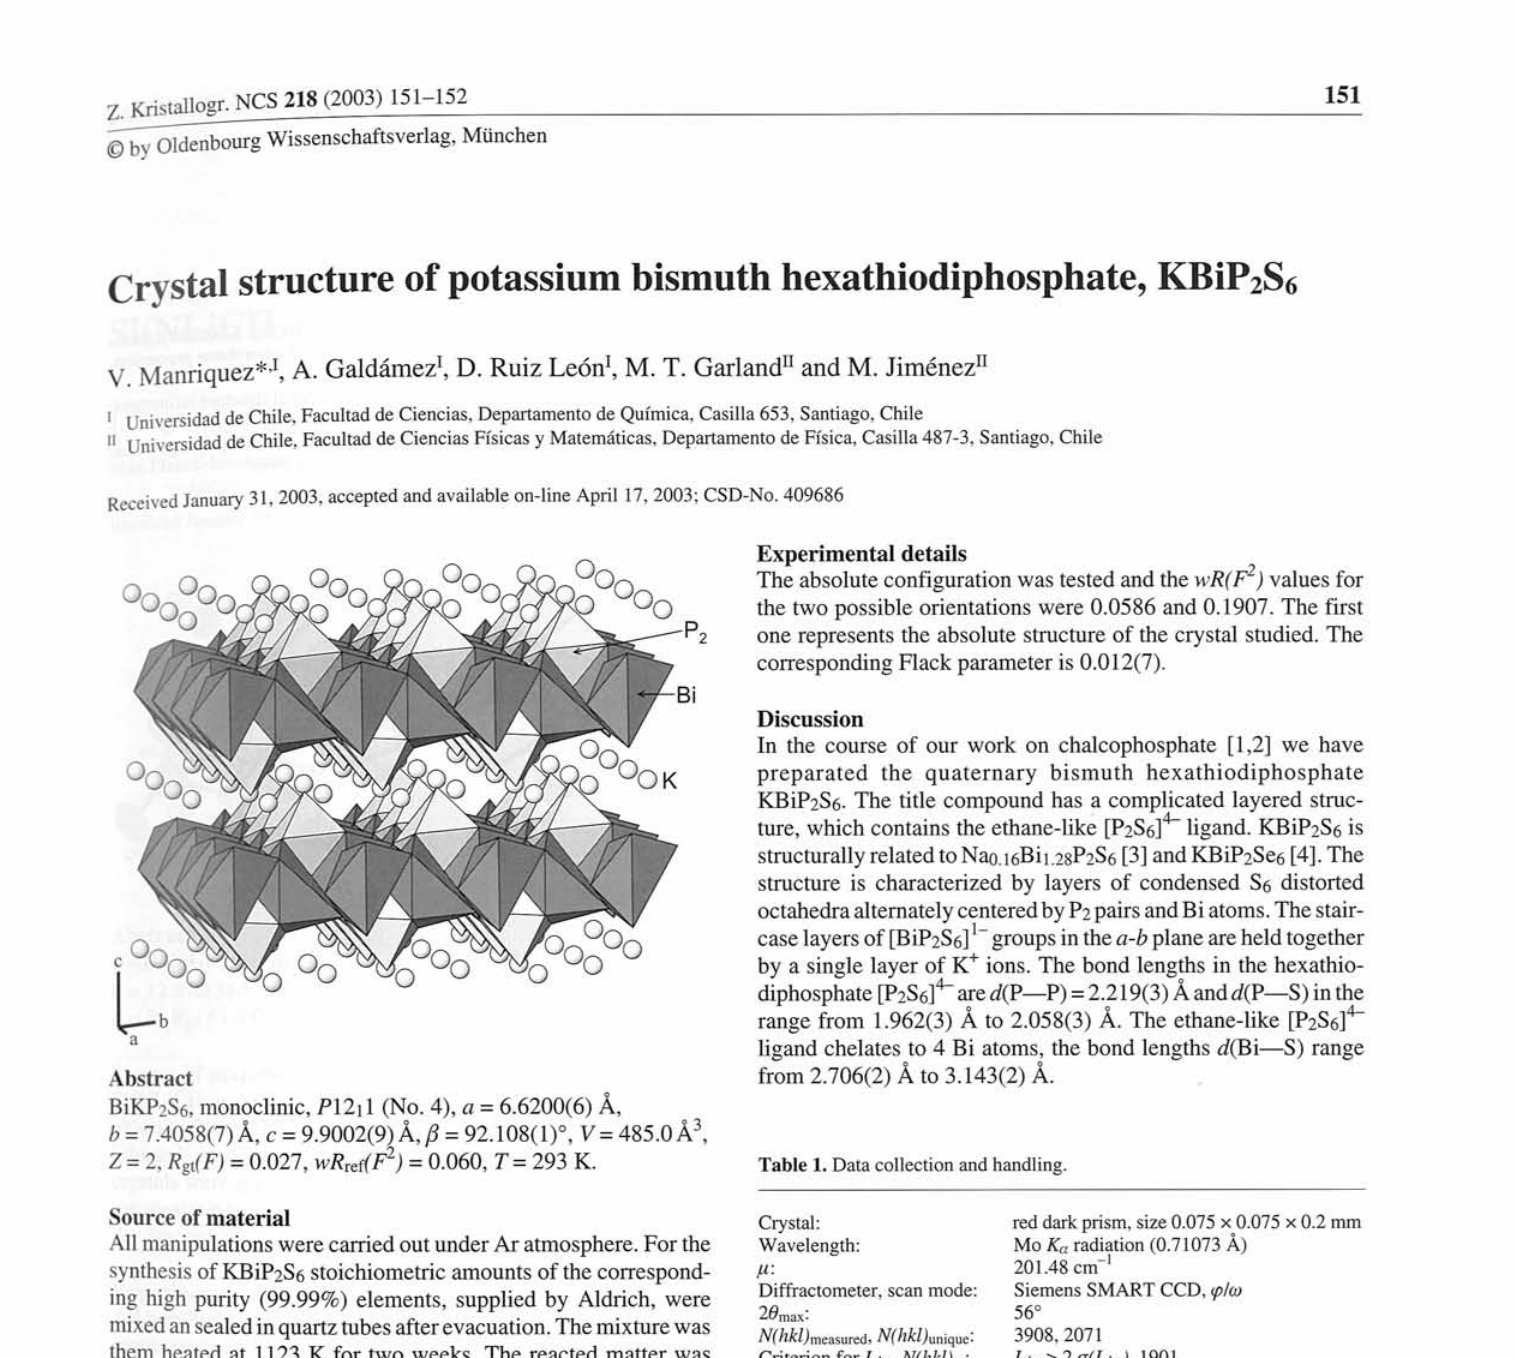
Table 2. Atomic coordinates and displacement parameters (in Â 2